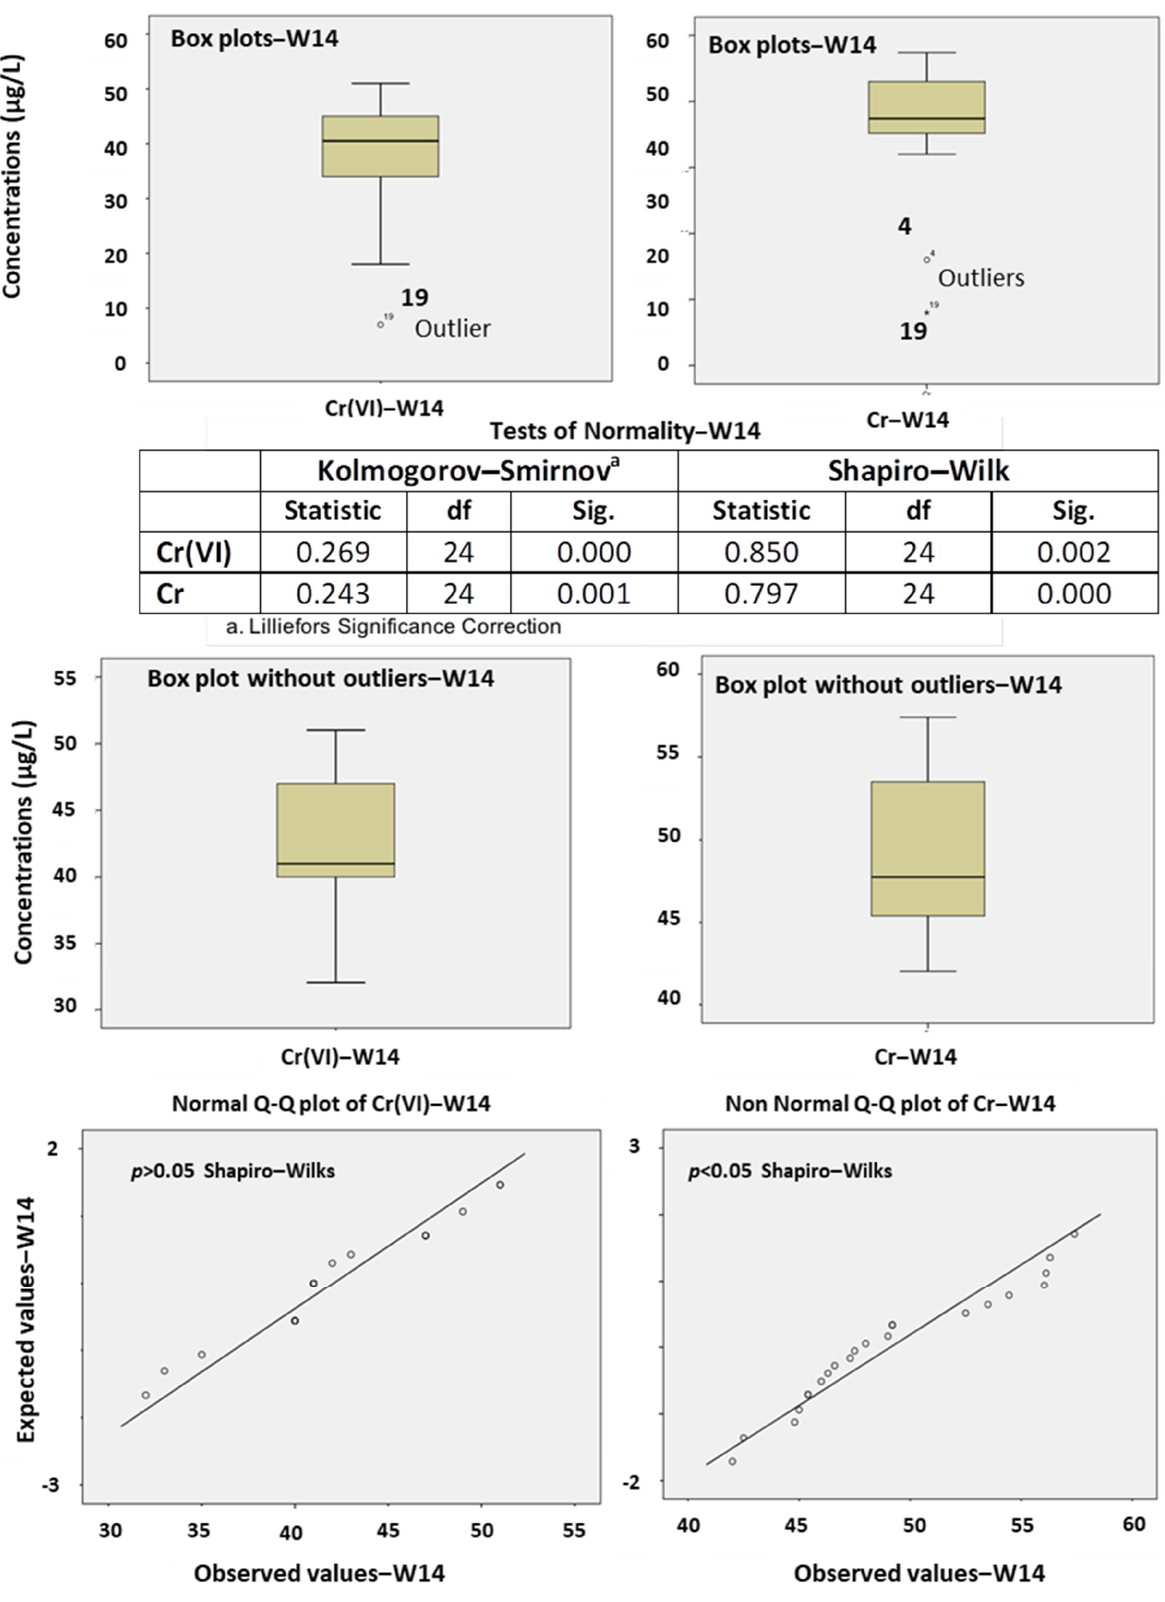
Figure 20. Box plots and normality tests for the natural spring “Elafakia”-W14 in western Vermio Mt. 583